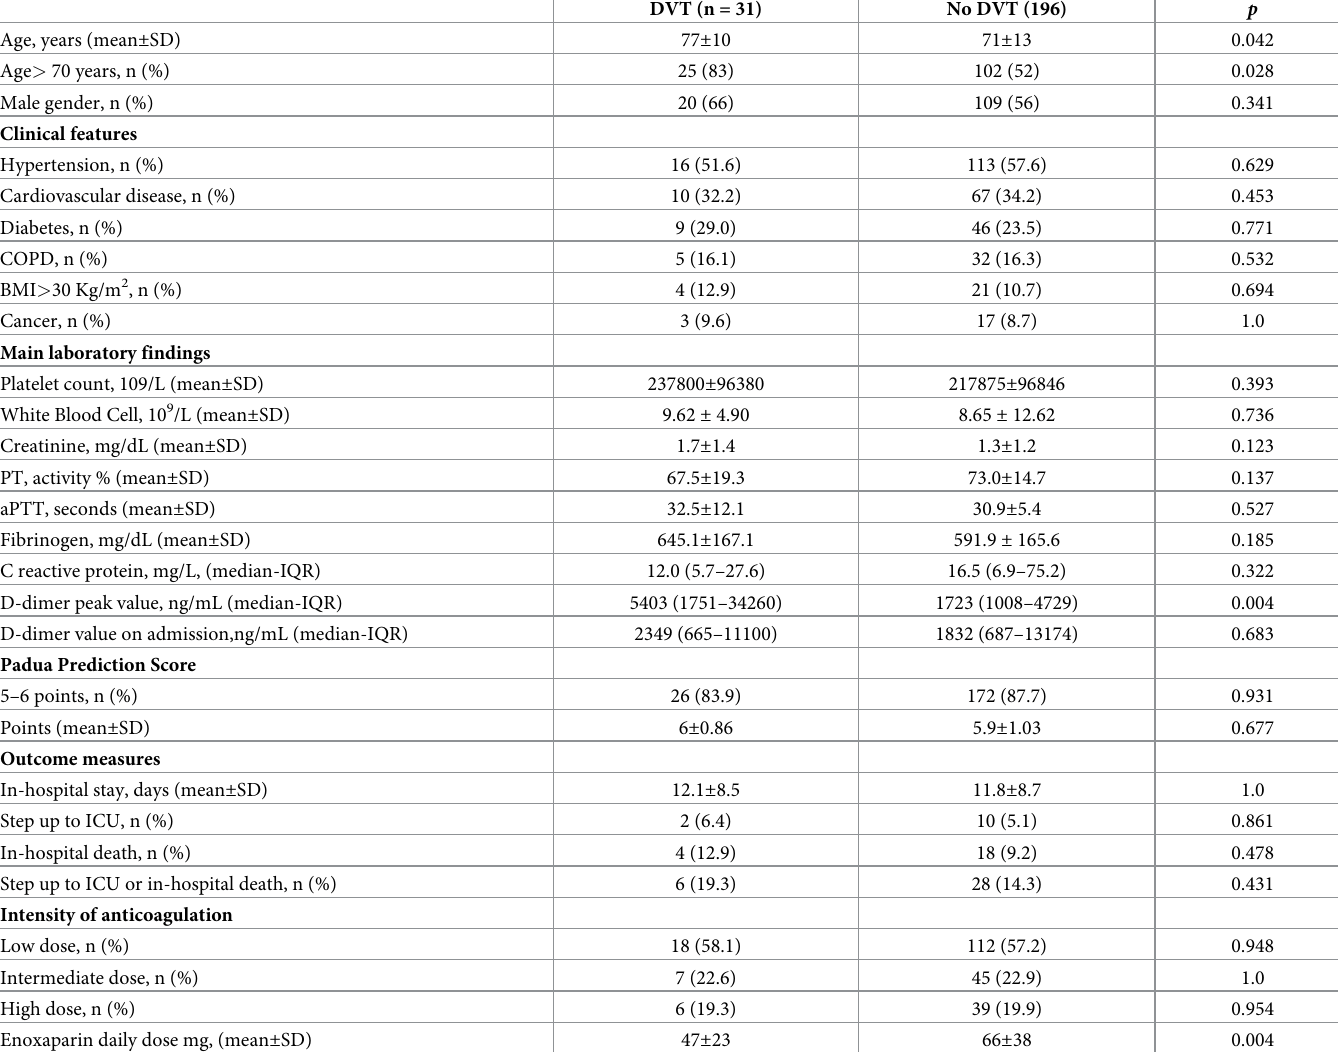
Table 2. Demographic, clinical characteristics and laboratory findings and outcomes of patients with e without